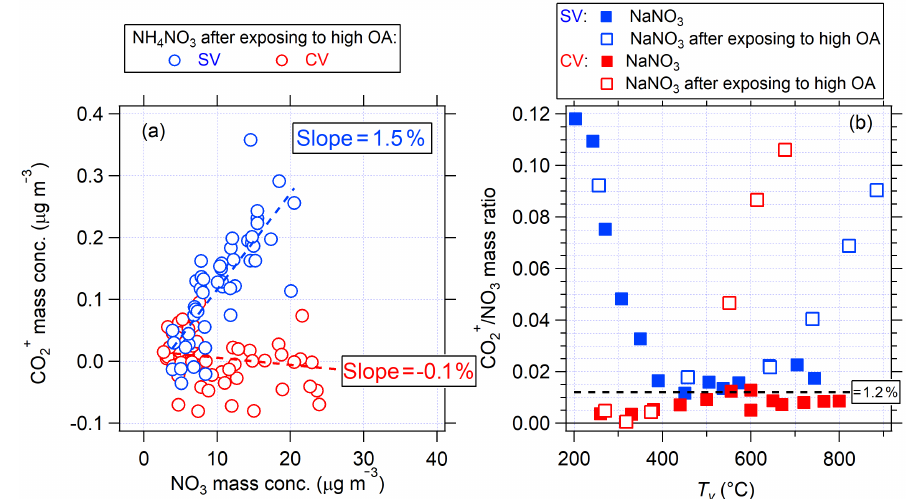
Figure 8. (a) Scatter plots of CO + and particulate nitrate signals when pure NH 4 NO 3 particles were sampled into two AMSs with a SV 2 and CV respectively. These data were collected after 4 days of exposing both AMS to a wide range of SOA mass concentrations (10– 1000µgm − 3 ) from chamber studies. (b) Ratios of CO + to particulate nitrate vs. T v . All data are in nitrate-equivalent units. The data for 2 NaNO 3 after being exposed to OA were collected during a period similar to those shown in Fig. 4a, while the other NaNO 3 data were collected in a different